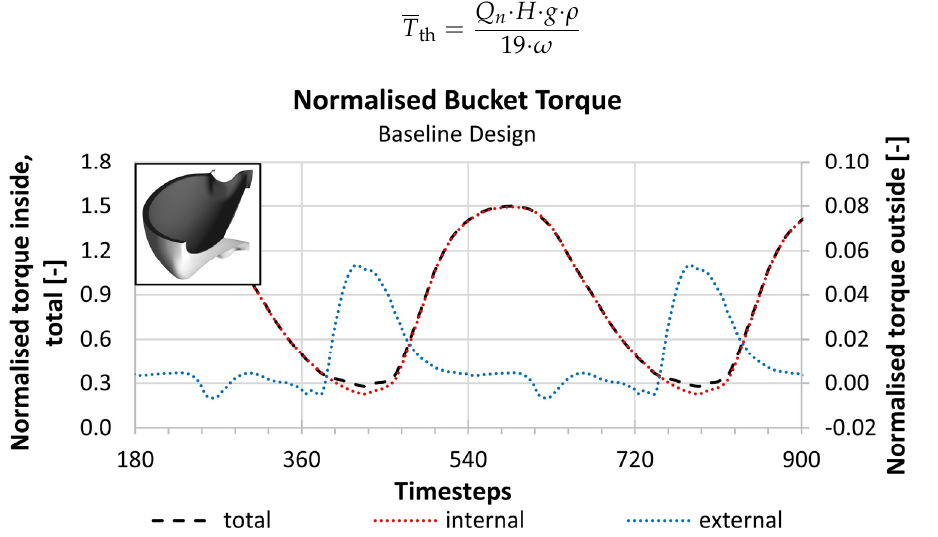
Figure 11. Normalised torque (baseline design).